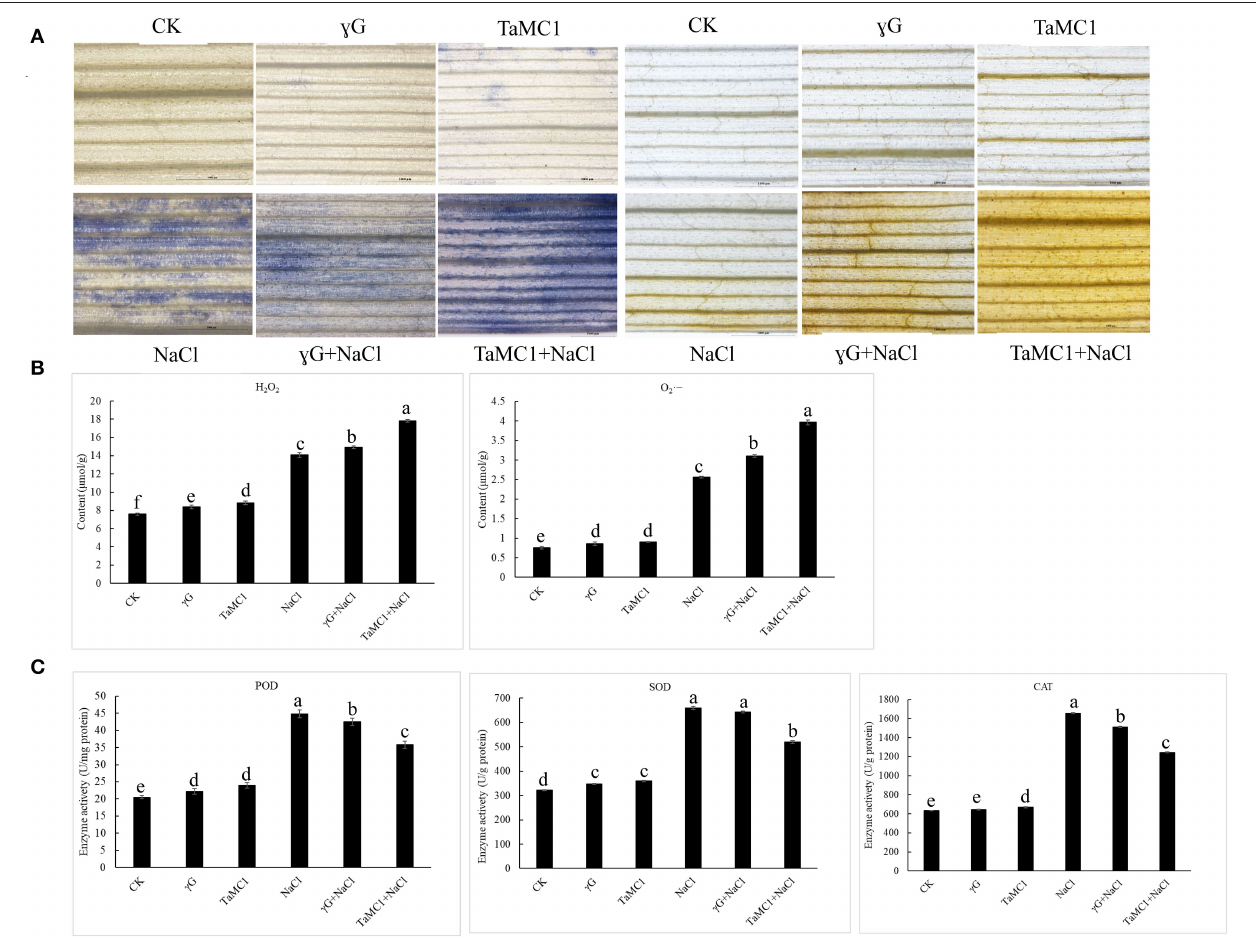
FIGURE 6 | The effect of silencing of TaMCA-Id on the ROS accumulation in leaves of wheat seedlings under NaCl stress. CK was the wild-type wheat seedlings. γ G was the BSMV-VIGS-GFP - inoculated wheat seedlings. TaMC1 was the BSMV-VIGS-TaMCA-Id - inoculated wheat seedlings. (A) NBT staining of the generation and accumulation of O − 2 in leaves of wheat seedlings, and DAB staining of the generation and accumulation of H 2 O 2 in leaves of wheat seedlings. (B) The content of O − 2 and H 2 O 2 in leaves of wheat seedlings. (C) The activities of POD, SOD, and CAT in leaves of wheat seedlings. Standard deviations are shown ( n > 3, ± SD, P < 0.05). All the experiments presented in this study were performed at least three times, and similar results were obtained.